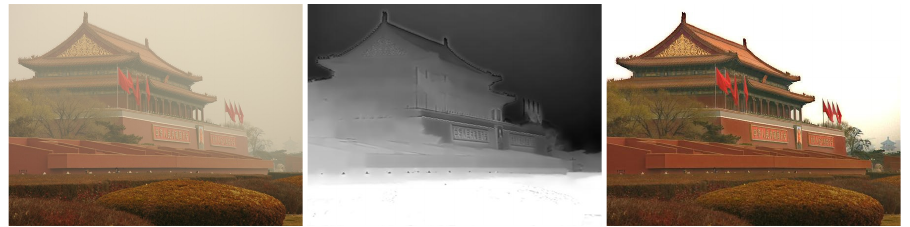
Figure 5. Visual results on a real-world hazy image. For left to right, the hazy input, the estimated transmission map, and the dehazed result.